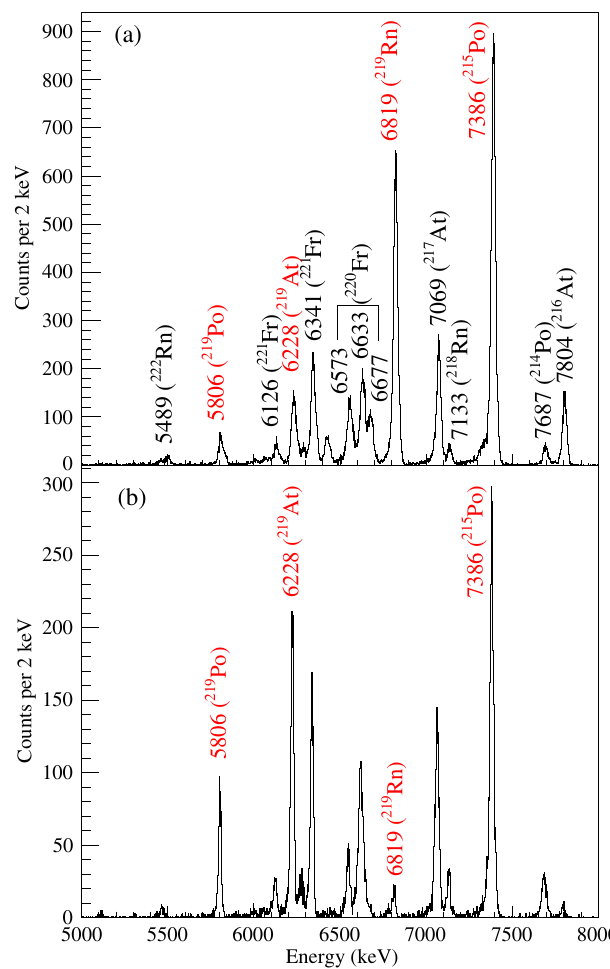
FIG. 13. α -decay energy spectrum for A ¼ 219 at the Windmill (a) implantation and (b) decay positions using 300-s implantation and observation periods with the lasers on polonium. The α -decay energies are in keV. Decays originating from the implantation of 219 Po are shown in red.